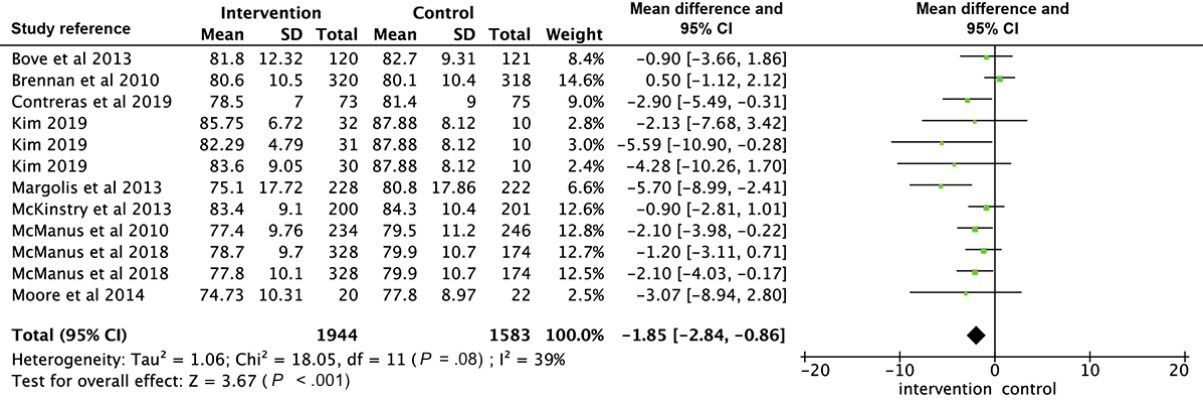
Figure 3. Forest plot of the difference of diastolic blood pressure between intervention and control group.